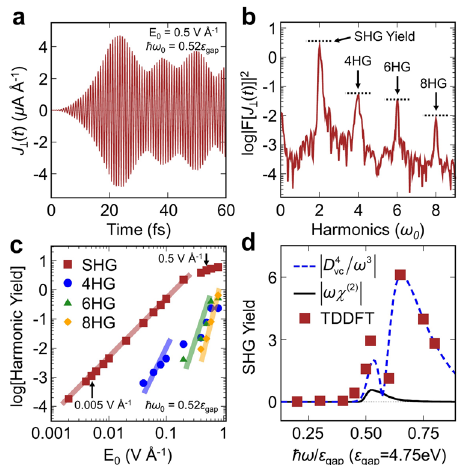
Fig. 5 The second harmonic Hall response to strong fi elds and contribution of the Berry curvature multipoles. a The real-time pro fi le of the transverse current density response of the pristine D 3h h-BN. The fi eld strength ( E 0 = 0.5 V Å − 1 ) is 100 times larger than that of Fig. 2c. b The Fourier transformation spectra of the current density given in a enveloped with a Gaussian function centered at 30 fs with the full-width at half- maximum (FWHM) of 20 fs. The x -axis is scaled with the applied fi eld frequency, ℏ ω 0 = 0.52 ε gap (where ε gap = 4.75 eV) and the y -axis is log scaled. Dashed lines and arrows depict the second harmonic generation (SHG) and high harmonic generation (HHG) yields. HHG consists of fourth (4HG), sixth (6HG), and eighth (8HG) harmonic generations. c The SHG (brown squares), 4HG (blue circles), 6HG (green triangles), and 8HG (yellow diamonds) yields for various fi eld strengths. Both x and y -axes are log scaled. Arrows show the fi eld strengths used in Fig. 2c – f (0.005 V Å − 1 ) and panels a , b , d (0.5 V Å − 1 ). The transparent brown, blue, green, and yellow lines represent the perturbative power rules ( E n ) for SHG, 4HG, 0 6HG, and 8HG yield, respectively. d is the comparison of the theoretical SHG susceptibility spectra (solid black line) and the SHG yields (brown fi lled squares) of the transverse current as given in c for 0.5 V Å − 1 . The blue dashed line is the Berry curvature 4th pole divided by ω 3 , the contribution of high-order corrections to SHG response. The light frequency is scaled with the